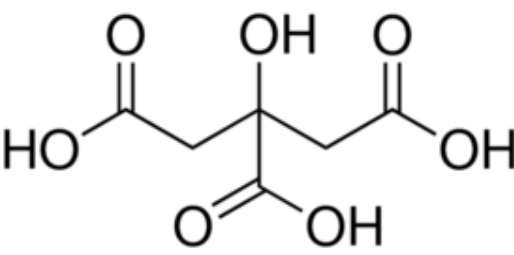
Figure 1. Chemical structure of citric acid.